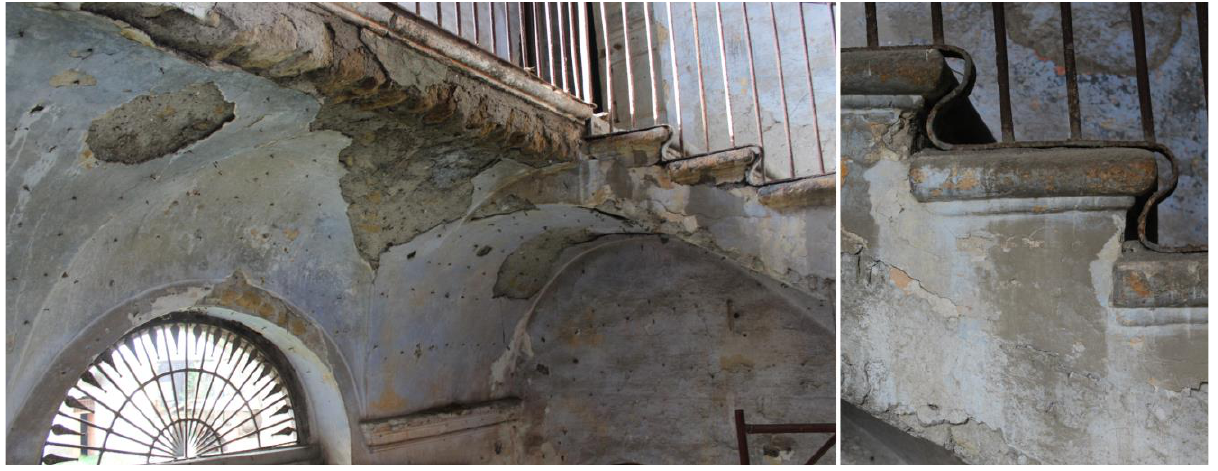
Figure 10. Details of the access staircase to the main floor.